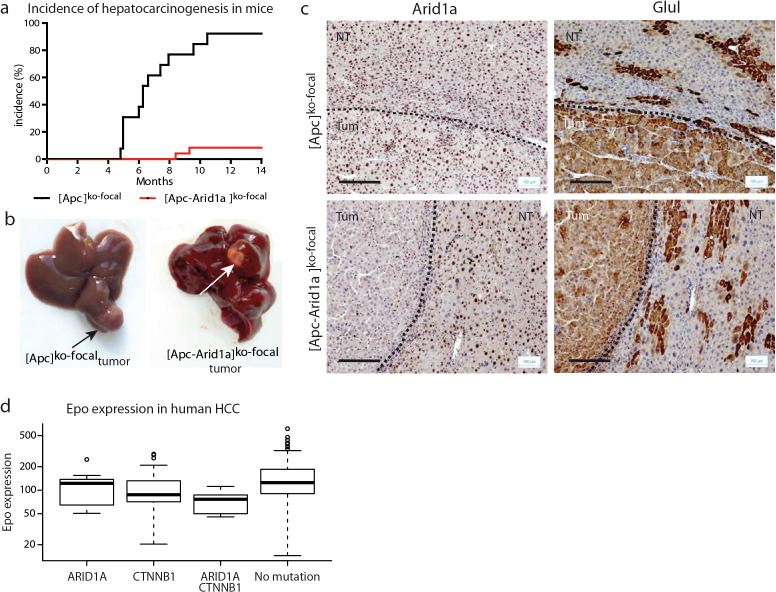
Hepatocarcinogenesis in β-catenin-activated and Arid1a-null context.(a–c) HCC incidence decrease in [Apc-Arid1a]ko-focal compared to [Apc]ko-focal mice. (a) Incidence of HCC was detected by ultrasound in [Apc]ko-focal (n = 13) and [Apc-Arid1a]ko-focal (n = 24) mice. (b) Two representative livers of ten-month-old [Apc]ko-focal and [Apc-Arid1a]ko-focal mouse livers presenting tumor. (c) Immunostaining of glutamine synthetase (Glul) and Arid1a in [Apc]ko-focal and [Apc-Arid1a]ko-focal liver sections. NT: non tumoral tissue; Tum: tumor; Scale bars = 200 μm. (d) EPO expression in human HCC depending on their CTNNB1 and ARID1A mutational status. Datasets in hepatocellular carcinoma were downloaded from the Cancer Genome Atlas (TCGA) data portal (http://tcga-data.nci.nih.gov). We extracted two types of molecular data including gene expression and somatic mutation using TCGA2STAT R package. Fours groups of tumors were clusterized based on mutation status: CTNNB1-mutated (n = 46), ARID1A-mutated (n = 11), CTNNB1/ARID1A-mutated (n = 5) and no CTNNB1 nor ARID1A mutations (n = 133). Analysis of variance and post-hoc tests were performed to test the association between EPO expression and mutation status.